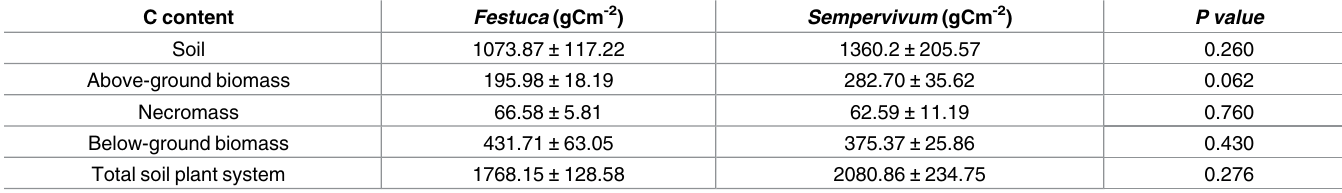
Table 4. Comparison of the C content in the plots of the two vegetation